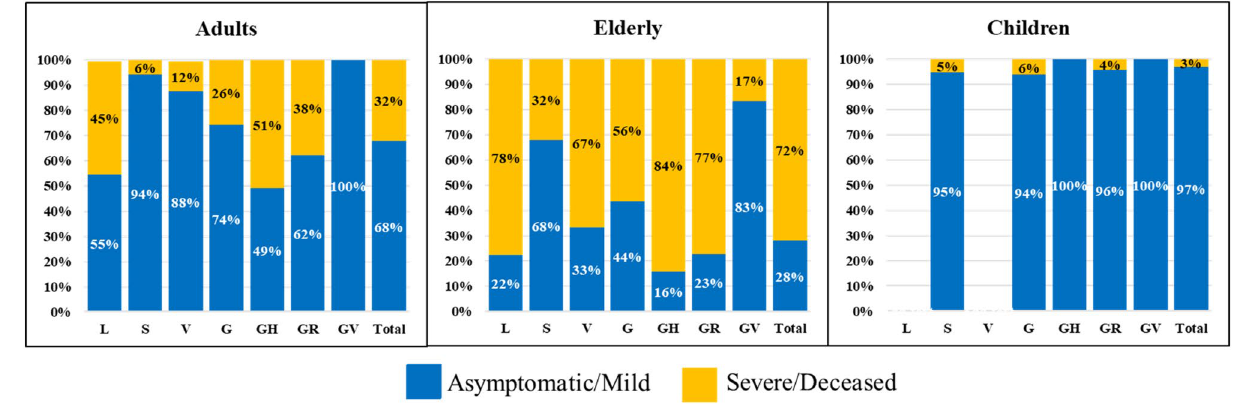
Figure 4. Clinical status of patients infected by SARS-CoV-2 of different clades in different age